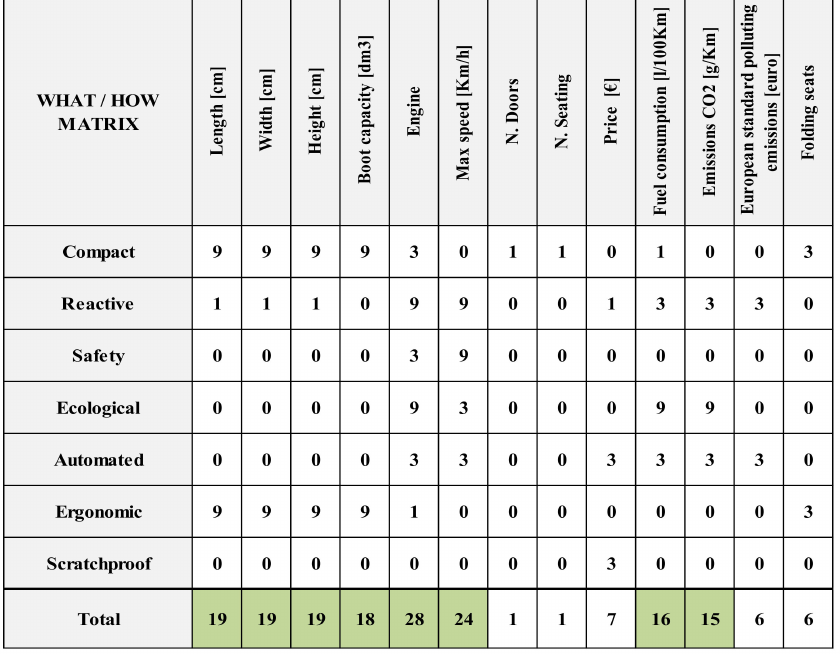
Figure 9. What / How